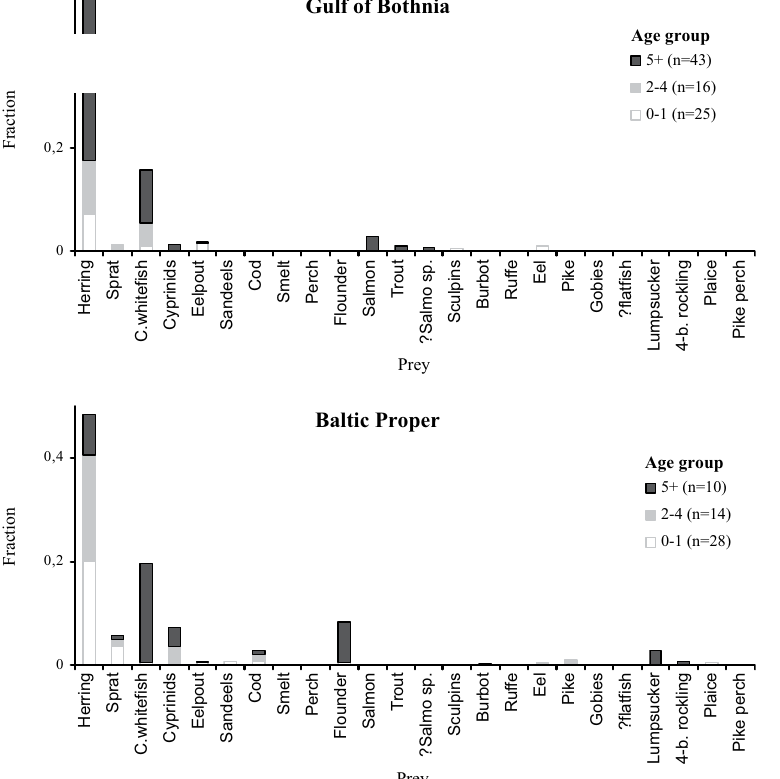
Fig. 7. Fraction of totally consumed biomass of prey taxa in grey seals belonging to age group 0-1, 2-4 and 5+, in the Gulf of Bothnia and the Baltic Proper, respectively. The consumed biomass of the various prey species has been calculated using the all data pooled model and mean val - ues of consumed biomass of the various prey species, from the methods B (all recovered hard-part structures) and C (otoliths